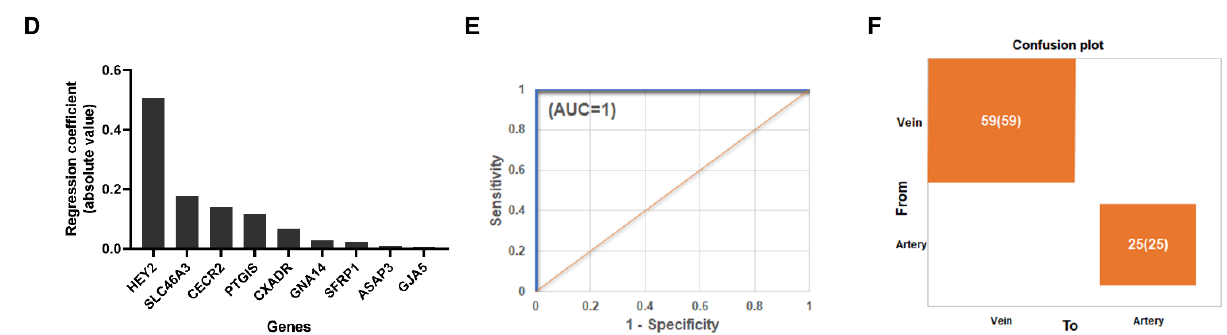
Figure 3. Transcriptional markers of arterial-venous identity for umbilical and placental vessels. ( A ) The PHATE plot shows the proximity between endothelial cells samples considering arterial-venous markers. ( B ) Bubble plots show the enriched BP and pathways for differentially expressed genes between arterial and venous endothelial cells. Bubble size represents the number of genes regulated for each term. ( C ) Hierarchical clustering of arterial-venous DEGs in umbilical and placental endothelial cells. ( D ) Lasso regression analysis addressed 9 genes highly correlated with arterio-venous nature dichotomy. ( E ) Logistic regression and ( F ) confusion matrix plot validates the high discriminating ability for 9 DEGs.